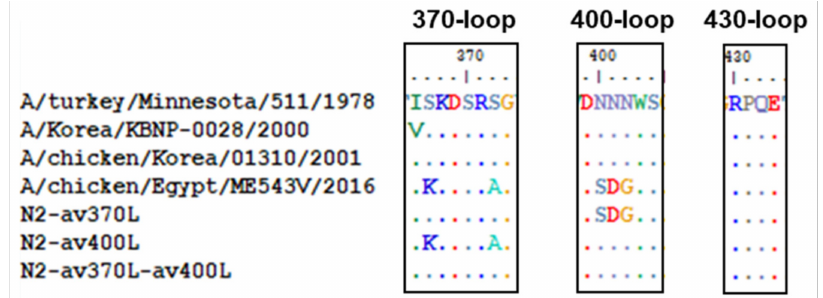
Figure 3. Comparison of the 2SBS amino acid sequences of H9N2 AIVs and mutated genes in this study. The 2SBS sequence of A/turkey/Minnesota/511/78(H9N2) was compared with others as the prototype. Three kinds of mutated NA genes were generated by replacing mutations of ME543V in the 370-loop (N2-av370L), the 400-loop (N2-av400L), or both (N2-av370L-av400L) with prototype sequences.